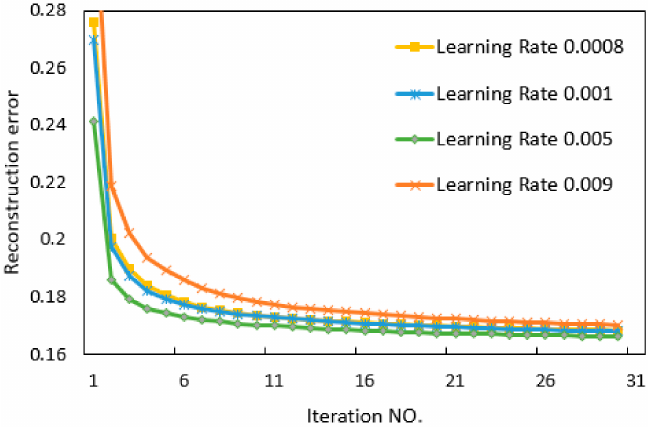
Figure 8. The reconstruction error of deep learning model for di ff erent learning